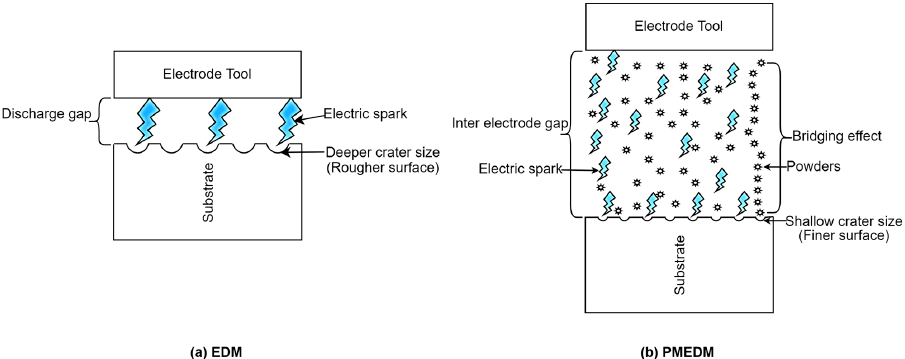
Figure 2. ( a ) Sparking mechanism in electric discharge machining process; ( b ) Sparking mechanism in powder-mixed electric discharge machining process.